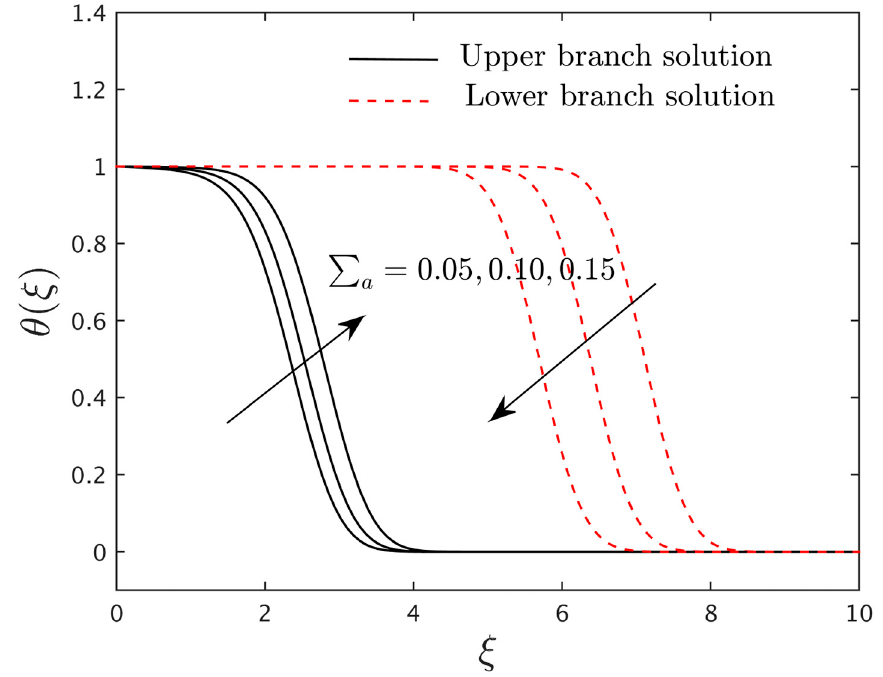
Figure 13. The temperature profiles θ ( ξ ) for the numerous values of Σ a when Pr a = 1.0, Sc a = 10.0, Pr = 6.2, ϕ = 0.025, and γ s = 0.5.